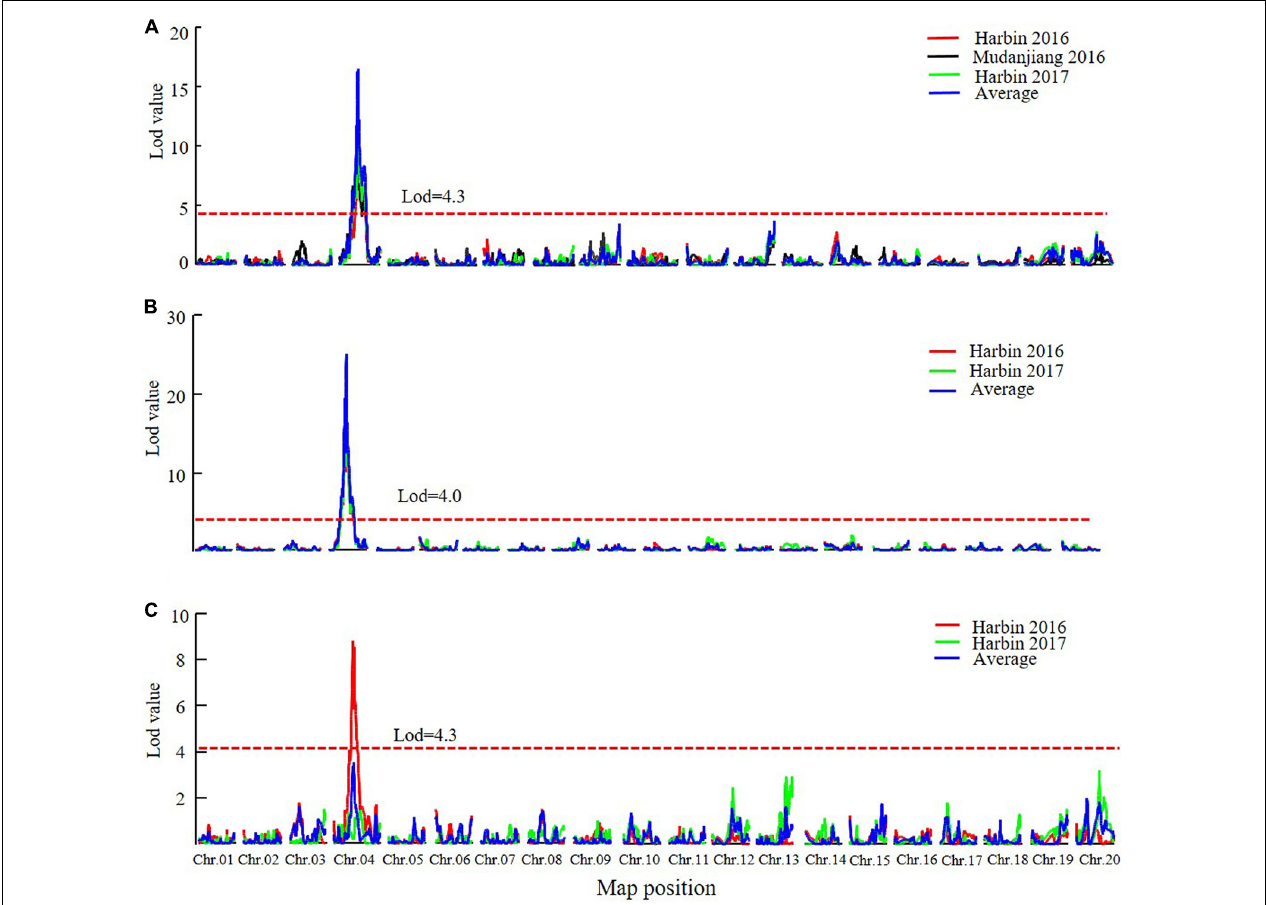
FIGURE 5 | The LOD value of the QTLs detected in DW RIL population under different environments and QTLs detected using the average data of different environments (MQM method). (A) QTLs of Flowering time trait (R1). (B) QTLs of maturity time trait (R8). (C) QTLs of reproductive period trait (RP). Harbin, 2016: The data of year 2016 in Harbin. Mudanjiang, 2016: The data of year 2016 in Mudanjiang. Harbin, 2017: The data of year 2017 in Harbin. Average: the average data in different environments. Chr.,